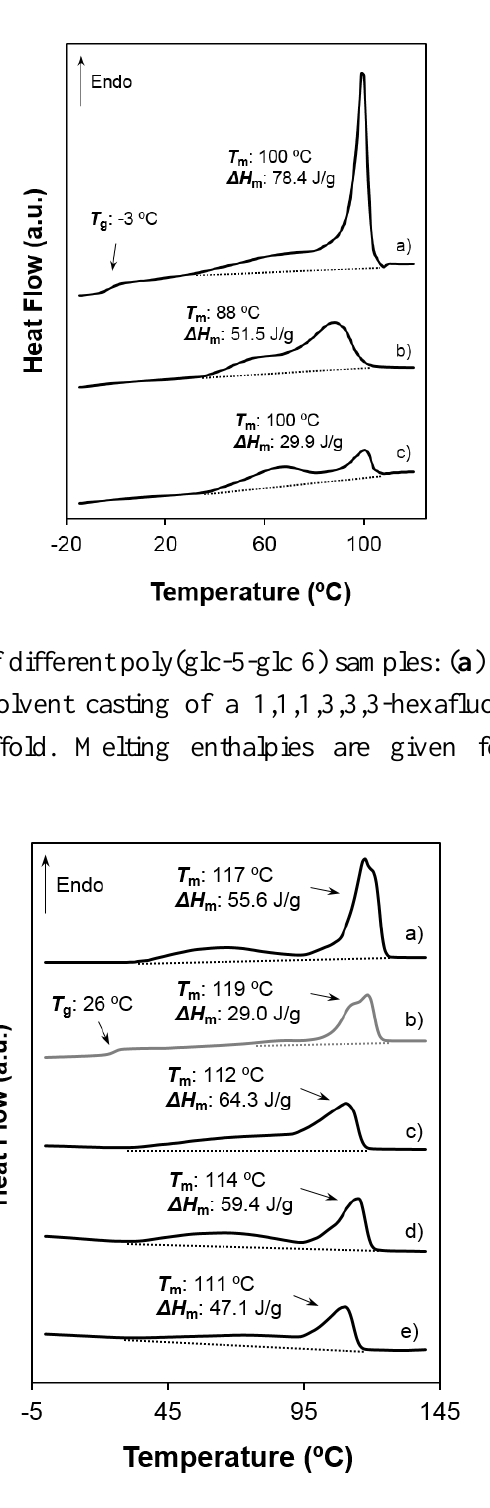
Figure 7. Heating scans of different poly(glc-6-glc 6) samples: ( a ) as-synthesized powder; ( b ) the same melt quenched sample; ( c ) film prepared from solvent casting of a 1,1,1,3,3,3-hexafluoroisopropanol solution; ( d ) electrospun scaffold and ( e ) electrospun scaffold loaded with 5% ( w / w ) of ketoprofen. Melting enthalpies are given for the overall set of endothermic